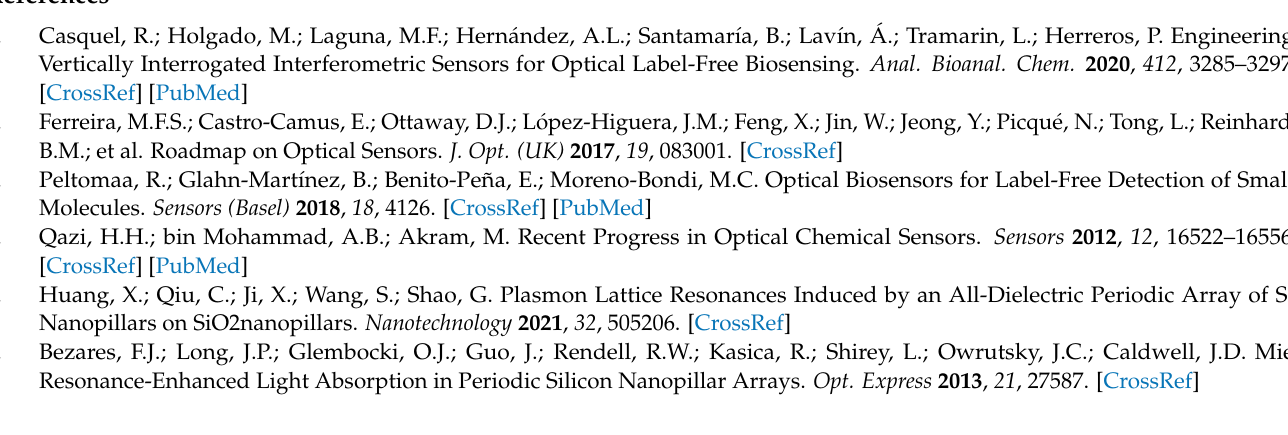
Figure S1: Image of the transparent electrochemical cell utilized for the characterization of the electrochemical behavior of ITO-coated samples. Masked sample, counter and reference electrodes, and N 2 bubbling system are indicated in the image. Figure S2: Voltagrams as a function of the scan rate recorded for sample R-NPs/ITO to estimate the ECSA. Similar voltagrams were also recorded for sample TF/ITO. Scan range was 0.05 to 0.25 V to avoid any Faradic contribution to the current signals and the medium was a phosphate solution, as indicated in the Materials and Methods Section of the paper. ECSA values could be estimated according to the expressions: C dl = d( ∆ j)/2dV d and ECSA = C dl /C s . Figure S3: Optical measurement-picture of the experimental setup ( left ) and a schematic figure of the procedure ( right , from [1]), including: ( a ) scheme of pillars immersed in water, ( b ) scheme of pillars in dry conditions, and ( c ) layout of the measurement system. Figure S4: Resonance shift as a function of the fluids RI, before and after ITO deposition: ( a ) experimental data, ( b ) calculated results. Figure S5: SEM imaging of R-NPs ( A and B , before ITO deposition) and R-NPs/ITO ( C and D , after ITO deposition). Both the increase in diameter and the change in shape directly suggest a correct deposition of ITO thin film on top of the nanostructures. Figure S6: SEM imaging of arrays of R-NPs/ITO after Au-NPs deposition ( A , B ) and negative control ( C , D ) of biological detection